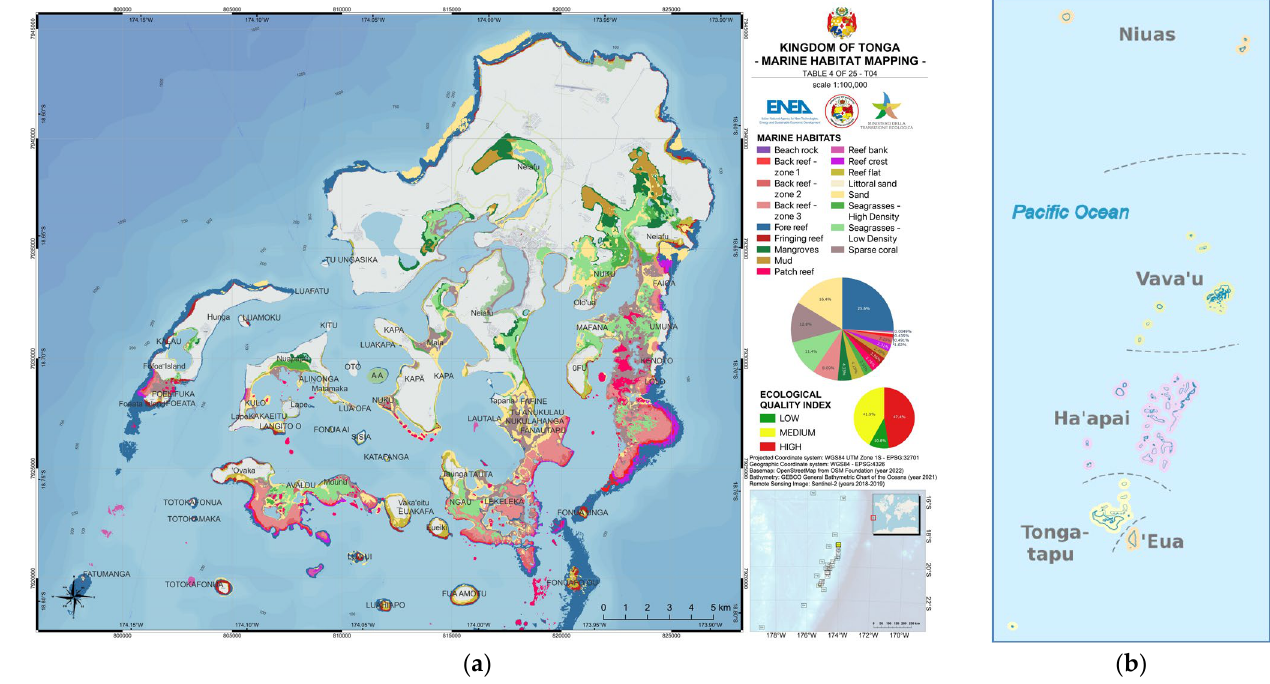
Figure 3. Figure 3. ( a ) The table N. 25 of the Atlas of the Marine Habitat of Tonga [35]. ( b ) The five Tonga ad- ministrative subdivisions or regions (source: https://gadm.org/ and Tonga Department of Statistics, accessed on 14 December